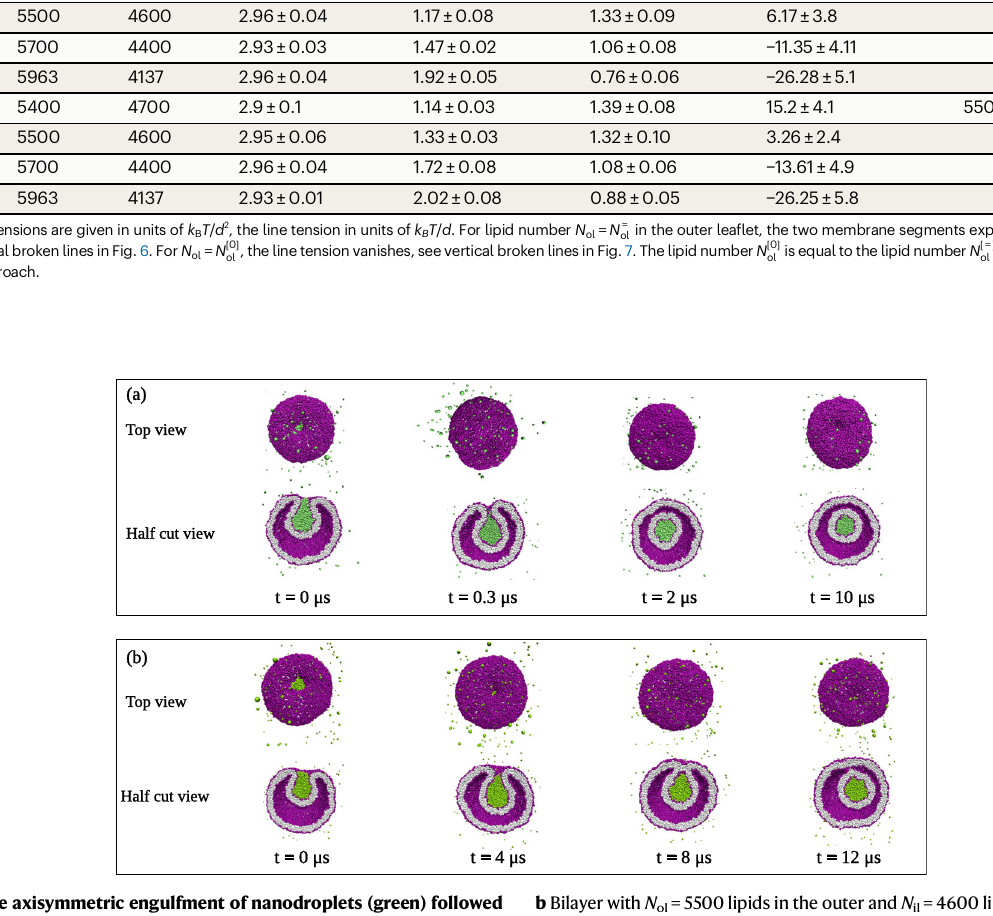
b Bilayerwith N ol =5500lipidsintheouterand N il =4600lipidsinthe innerlea fl et. Fig. 3 | Complete axisymmetric engulfment of nanodroplets (green) followed by division of nanovesicle (purple-gray) into two nested daughter vesicles. The membrane neck now closes at t =4 μ s and undergoes fi ssion at t =9 μ s, again a Nanovesicle formed by a lipid bilayer with N ol =5400 lipids in the outer and generating a small intraluminal vesicle around the droplet. More details on this fl et.Attime t =0,thedropletispartiallyengulfedby N shape evolution are provided by the Movies S3 and S4, which also demonstrates il =4700lipidsintheinnerlea the vesicle membrane, which forms an open membrane neck. At t =0.3, the neck that the morphology with two nested vesicles remains unchanged up to 30 μ s. In closes and the droplet becomes completely engulfed. The neck then undergoes both( a )and( b ),thenanovesicleshaveasizeof37nm,thedropletshaveadiameter fi ssion at t =2 μ s, thereby generating a small intraluminal vesicle around the dro- of 11.2 nm, and the vesicle volume is equal to ν =0.6 during the whole endocytic plet.MoredetailsontheshapeevolutionareprovidedbytheMoviesS1andS2;and